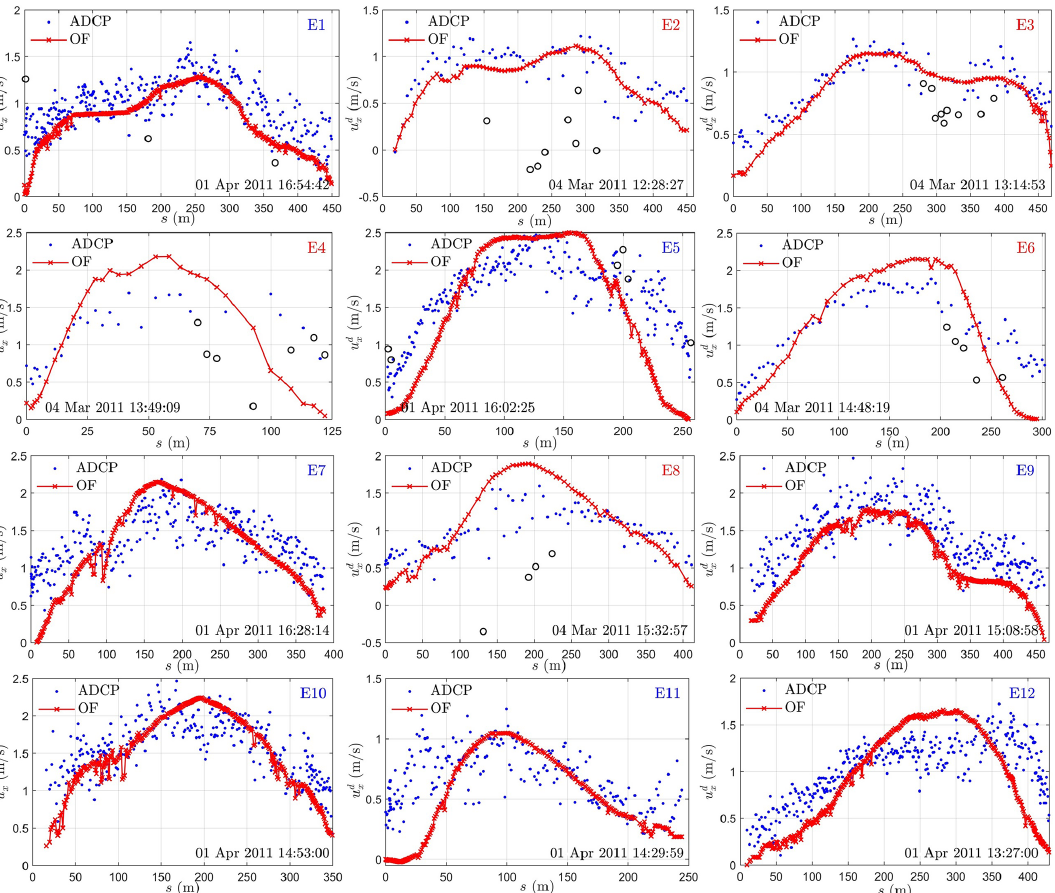
Figure A5. A comparison of depth-averaged velocity component along x from ADCP surveys and CFD modeling at E1–E12. Black circles denote measured outliers visually determined from Fig. A5 or Fig.